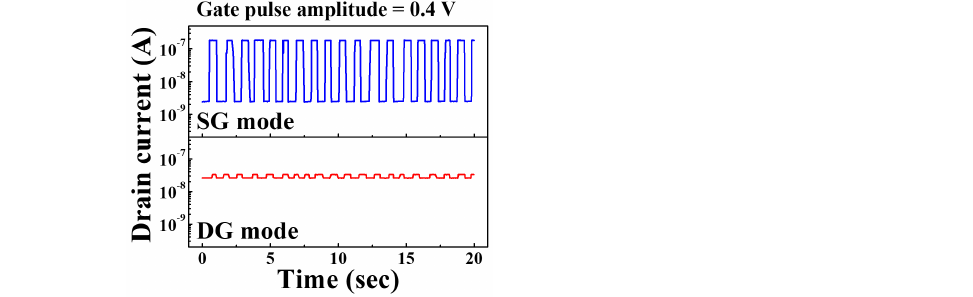
Figure 6. The fluctuation of drain current due to square wave pulse (assuming noise) applied to the voltage sweep under SG and DG operation mode.